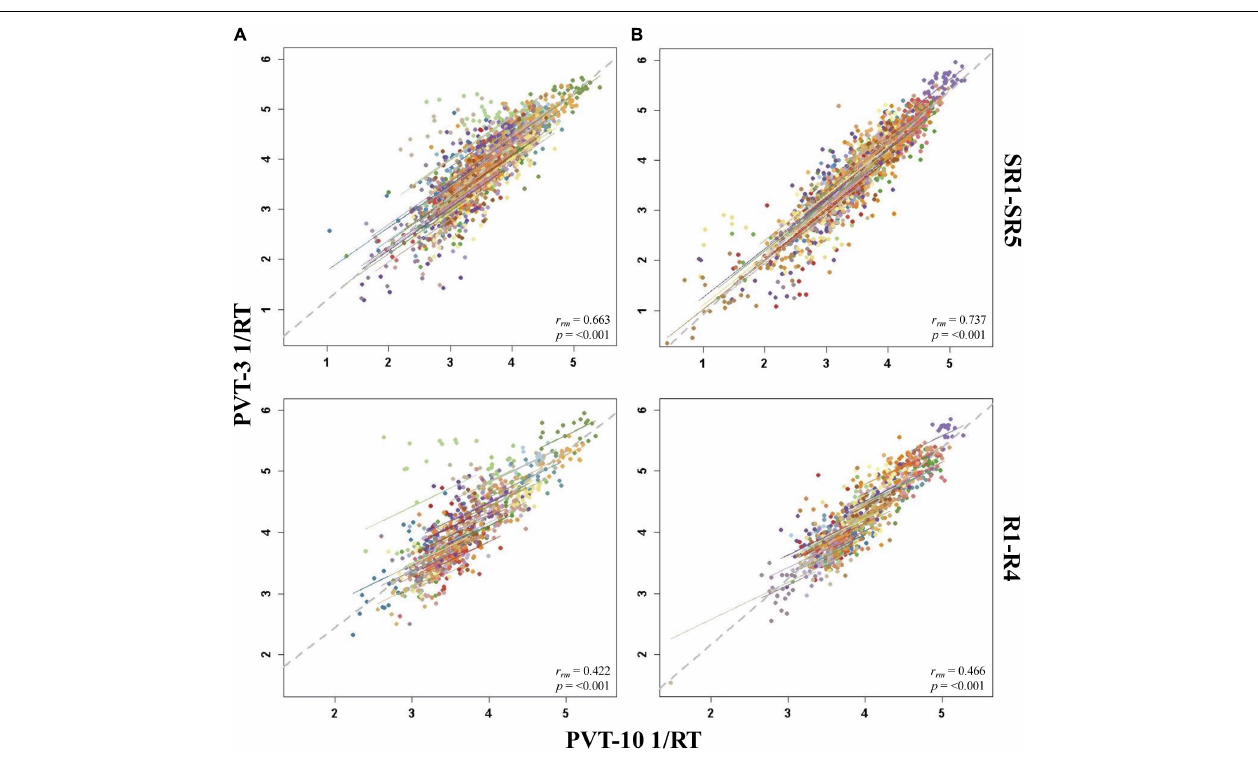
FIGURE 4 | Rmcorr plots of repeated-measures correlations between 10-min Psychomotor Vigilance Test (PVT-10) and 3-min Psychomotor Vigilance Test (PVT-3) response speed (1/RT) by study phase for Condition A (A) and Condition B (B) . Each color represents a distinct participant with each point showing performance on both measures at one time point while the corresponding line shows the rmcorr fit for that participant (Bakdash and Marusich, 2020; R Core Team, 2020). The gray dashed line represents the regression line obtained by ignoring repeated measurements and treating the data as independent observations; r rm represents the common within-individual association (rmcorr). Rmcorr effect sizes were interpreted as follows: 0.00–0.29, negligible; 0.30–0.49, weak; 0.50–0.69, moderate; 0.70–0.89, strong; and 0.90–1.00, very strong. Included time points were as follows: sleep restriction day one from 0800 h through sleep restriction day five